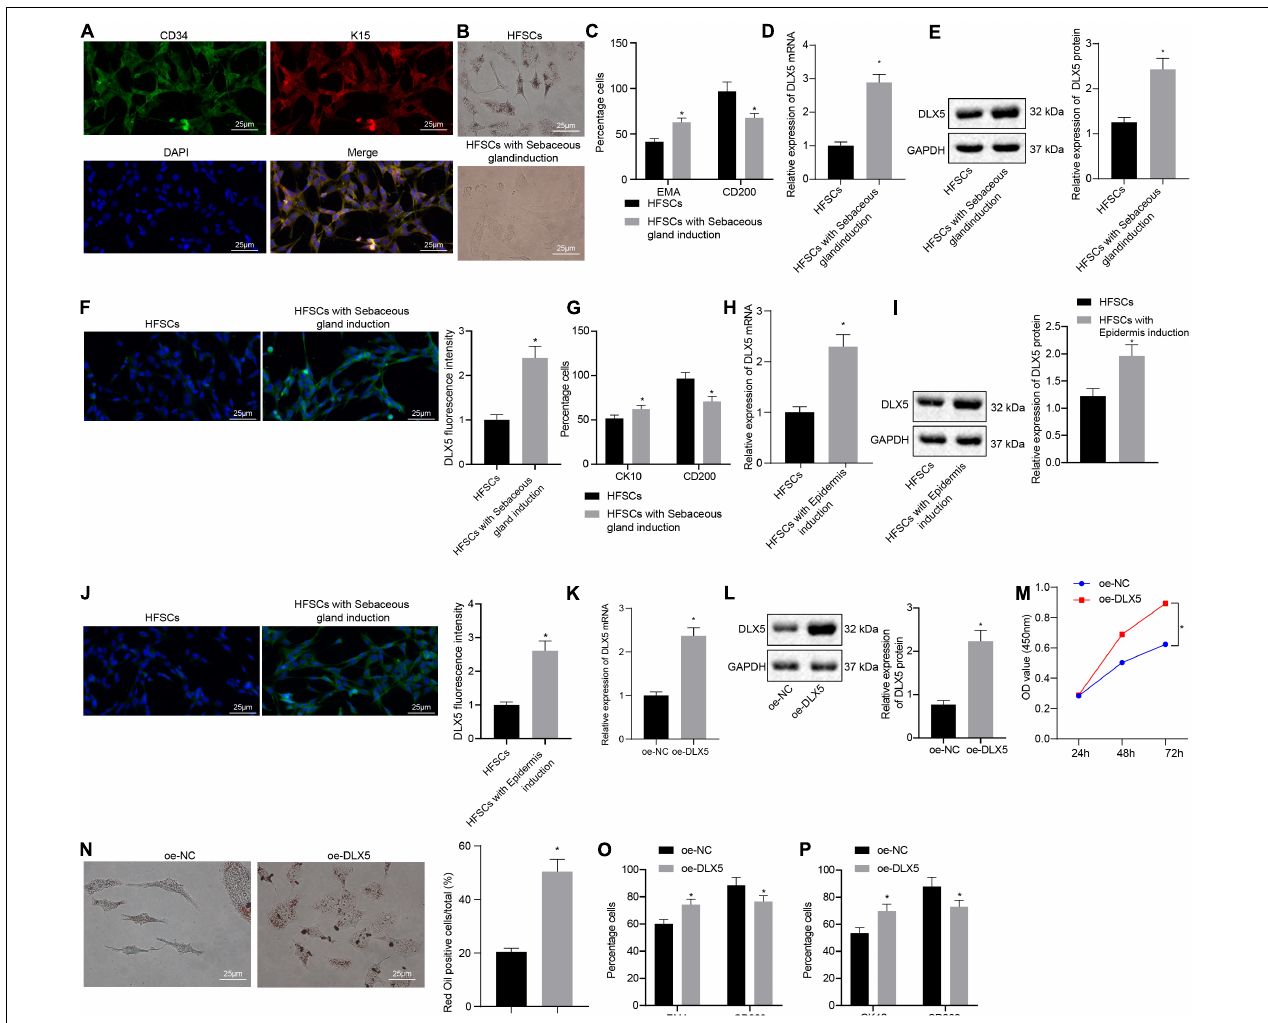
FIGURE 1 | Overexpression of DLX5 in HFSCs promotes HFSC differentiation. (A) HFSC markers CD34 and K15 were identified by immunofluorescence assay for HFSC isolation (scale bar = 25 µ m). (B) Oil red O staining before and after differentiation of HFSCs into sebaceous gland cells (scale bar = 25 µ m). * p < 0.05 compared with HFSCs. (C) Flow cytometry detected the expression of EMA, a lipid droplet marker, and CD200, a specific marker of HFSCs, before and after HFSCs were differentiated into sebaceous gland cells. * p < 0.05 compared with HFSCs. (D) DLX5 mRNA expression in HFSCs after differentiation into sebaceous gland cells determined by RT-qPCR. * p < 0.05 compared with HFSCs. (E) DLX5 protein level in HFSCs after differentiation into sebaceous gland cells determined by Western blot analysis. * p < 0.05 compared with HFSCs. (F) DLX5 fluorescence intensity in HFSCs after differentiation into sebaceous gland cells determined by immunofluorescence assay. * p < 0.05 compared with HFSCs. (G) Detection of keratin CK10 and CD200 expression using flow cytometry, before and after the differentiation of HFSC cells into epidermal cells. * p < 0.05 compared with HFSCs. (H) DLX5 mRNA expression in HFSCs after differentiation into epidermal cells measured using RT-qPCR. * p < 0.05 compared with HFSCs. (I) DLX5 protein level in HFSCs after differentiation into epidermal cells measured using Western blot analysis. * p < 0.05 compared with HFSCs. (J) DLX5 fluorescence intensity in HFSCs after differentiation into epidermal cells measured using immunofluorescence assay. * p < 0.05 compared with HFSCs. (K) DLX5 mRNA expression in HFSCs determined by RT-qPCR. * p < 0.05 compared with treatment of oe-NC. (L) DLX5 protein expression in HFSCs determined by Western blot analysis. * p < 0.05 compared with treatment of oe-NC. (M) CCK-8 assay results of the proliferation rate in HFSCs after DLX5 overexpression. * p < 0.05 compared with treatment of oe-NC. (N) Oil red O staining before and after differentiation of HFSCs into sebaceous gland cells (scale bar = 25 µ m). * p < 0.05 compared with treatment of oe-NC. (O) Flow cytometry detection of EMA and CD200 expression. * p < 0.05 compared with treatment of oe-NC. (P) Flow cytometry detection on the keratin CK10, and CD200 expression. * p < 0.05 compared with treatment of oe-NC. The two groups were compared by unpaired t test. Data among multiple groups at different time points were compared using two-way ANOVA and Bonferroni test. The experiment was repeated three